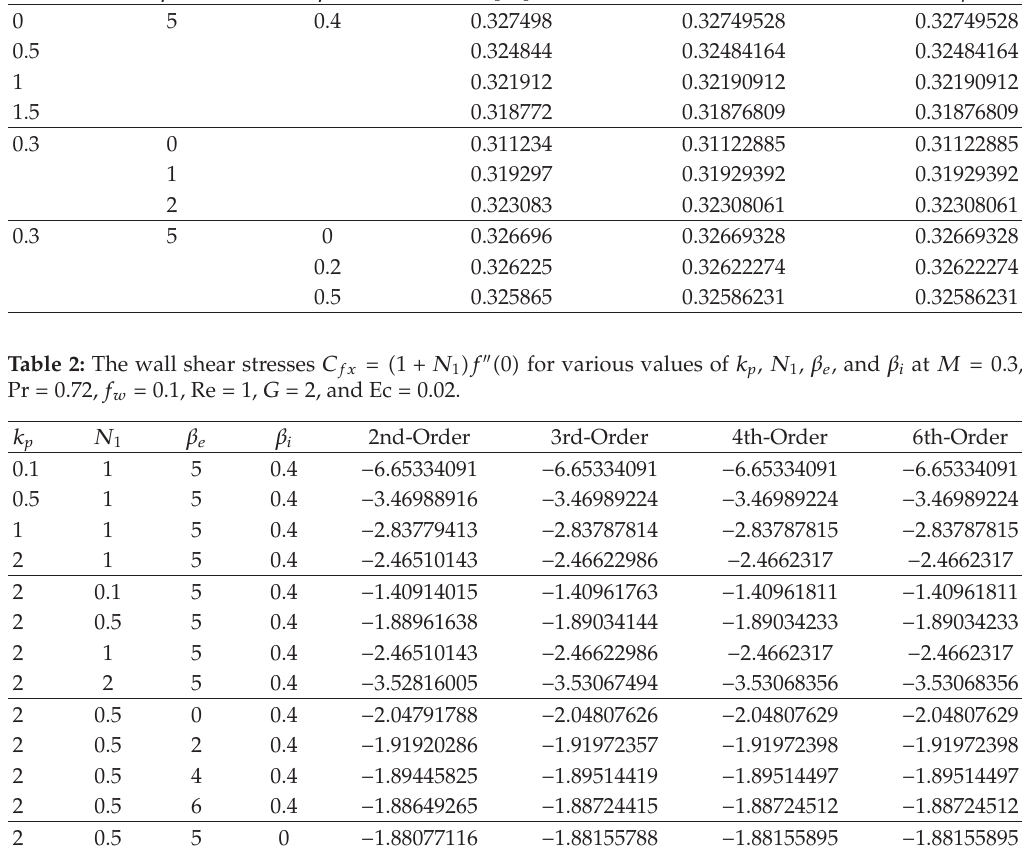
Table 1: Comparison of the present results (cid:6) 4th-order (cid:7) for the local Nusselt number − θ (cid:4) (cid:6) 0 (cid:7) against the bvp 4 c results and the results of (cid:4) 12 (cid:5) for various values of β e , β i and M at Pr (cid:8) 0 . 72 ,β 2 (cid:8) 0 . 5 ,f w (cid:8) 0 . 1,